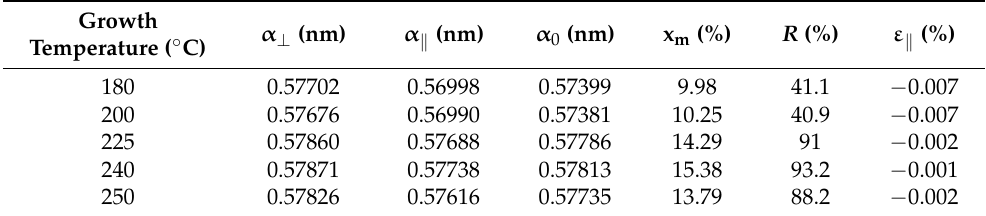
Table 1. Out-of-plane ( α ⊥ ) lattice constants, in-plane ( α (cid:107) ) lattice constants, unstrained lattice con- stants ( α 0 ), measured Sn content (x m ), degree of strain relaxation ( R ) and in-plane strain ( ε (cid:107) ) of the Ge 1 − x Sn x